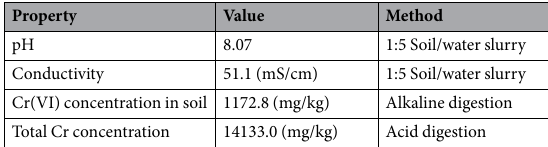
Table 2. Physical and chemical characteristics of the soil